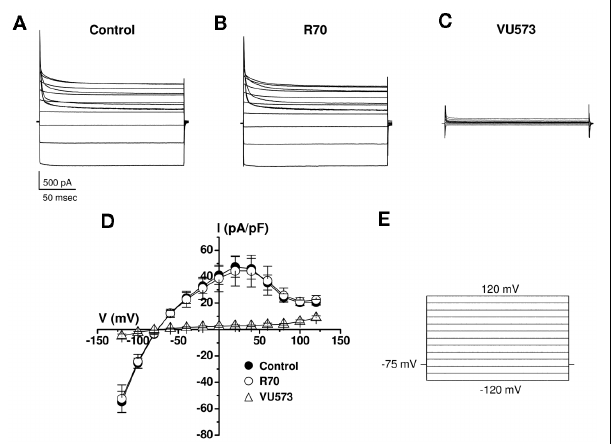
FIGURE 6 | Lack of effect of R70 on wild type Kir7.1 activity. Average Kir7.1 current traces ( n = 4 each) recorded in the absence (A) or presence of (B) 10 μ M R70 or (C) 10 μ MVU573. (D) Mean ± SEM ( n = 4) current–voltage Kir7.1 relationships recorded in the indicated conditions using the voltage-clamp protocol shown in (E)